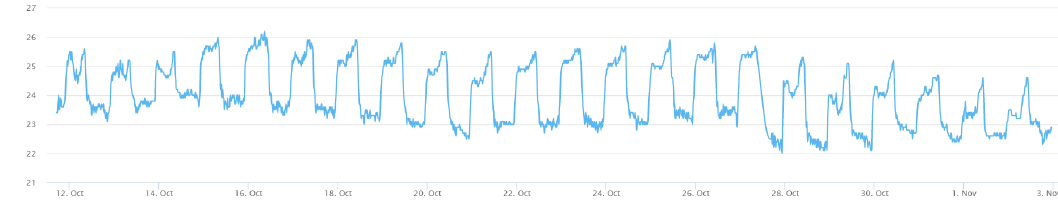
Figure 22. The temperature observations from the device 24 between 2018/10/12 to 2018/11/02.